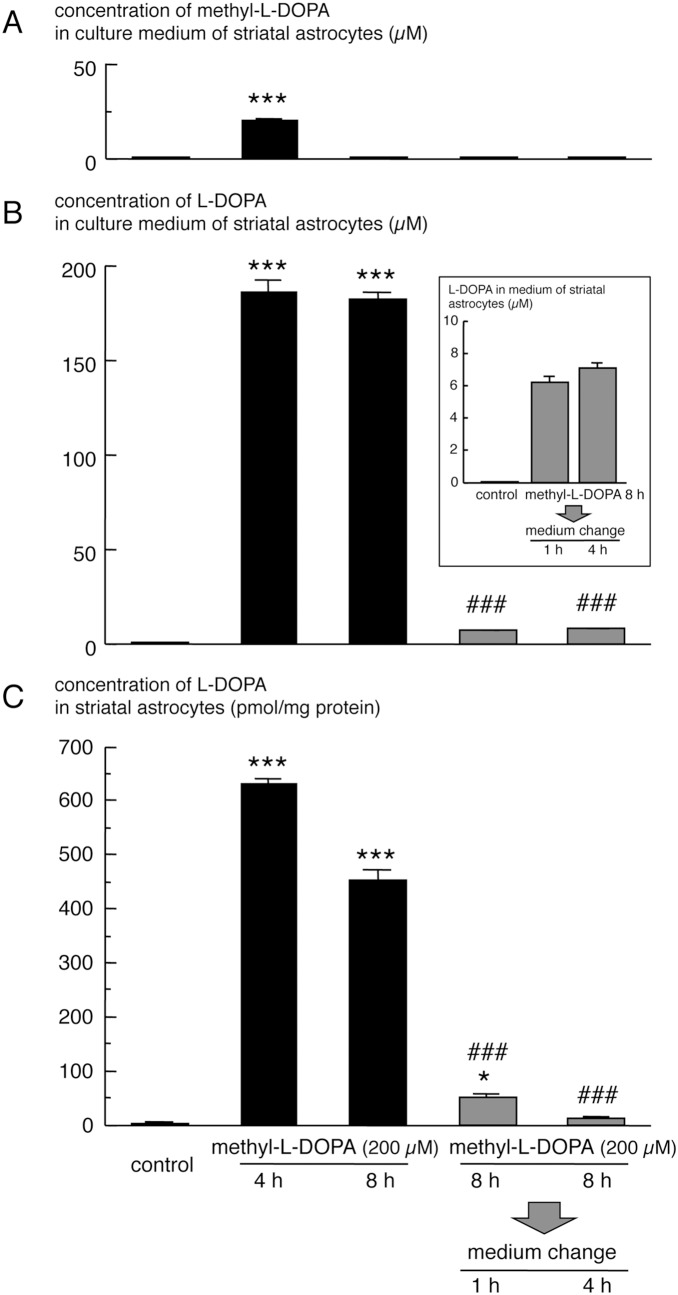
Changes in extracellular and intracellular L-DOPA concentration in methyl-L-DOPA-pretreated primary cultured striatal astrocytes after withdrawal of L-DOPA.Striatal astrocytes were treated with methyl-L-DOPA (200 µM) for 4 h or 8 h (filled bar). Furthermore, astrocytes pre-treated with methyl-L-DOPA for 8 h were incubated in fresh medium for 1 h or 4 h (gray bar). The concentration of methyl-L-DOPA (A) and L-DOPA (B) in culture media, and intracellular concentration of L-DOPA (C) in striatal astrocytes. Inset highlights the changes in L-DOPA concentration in fresh medium after removal of extracellular L-DOPA. Values are mean ± SEM (n = 4). *p<0.05, ***p<0.001 vs. control vehicle-treated, ###p<0.001 vs. 8-h methyl-L-DOPA-treated group.